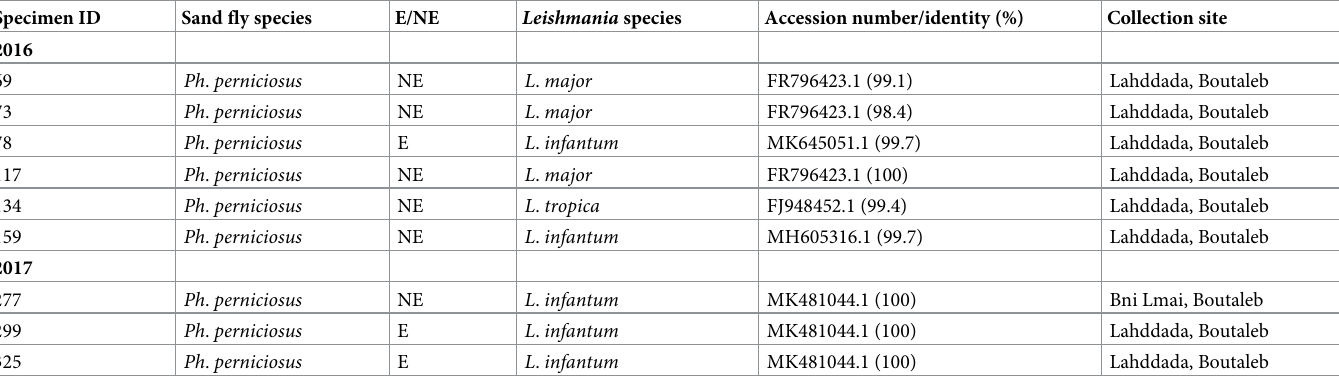
Table 3. Phlebotomine sand flies positive for Leishmania spp., accordingly to year and site of collection in Setif, North-Eastern Algeria. Accession numbers of ITS2 reference sequences and percentage of identity are reported. Specimen